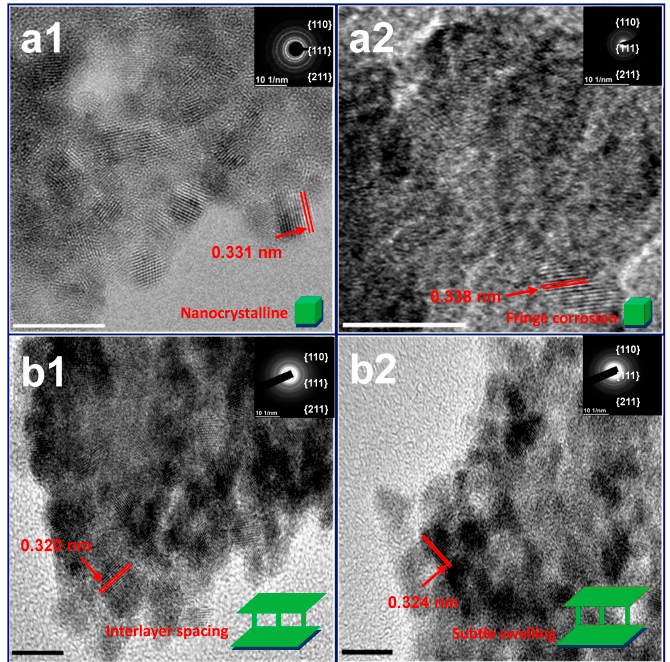
Figure 2. The subtle variation of Sn-EDTMP nanoparticles is revealed by high-resolution TEM images and electron diffraction patterns. Samples a,b are Sn-EDTMP5 and Sn-EDTMP3. The ( a1 , b1 ), ( a2 , b2 ) corresponds to the pristine and leached Sn-EDTMP, respectively. The electron diffraction patterns have been calibrated as inset and the scale bar is 5 nm.